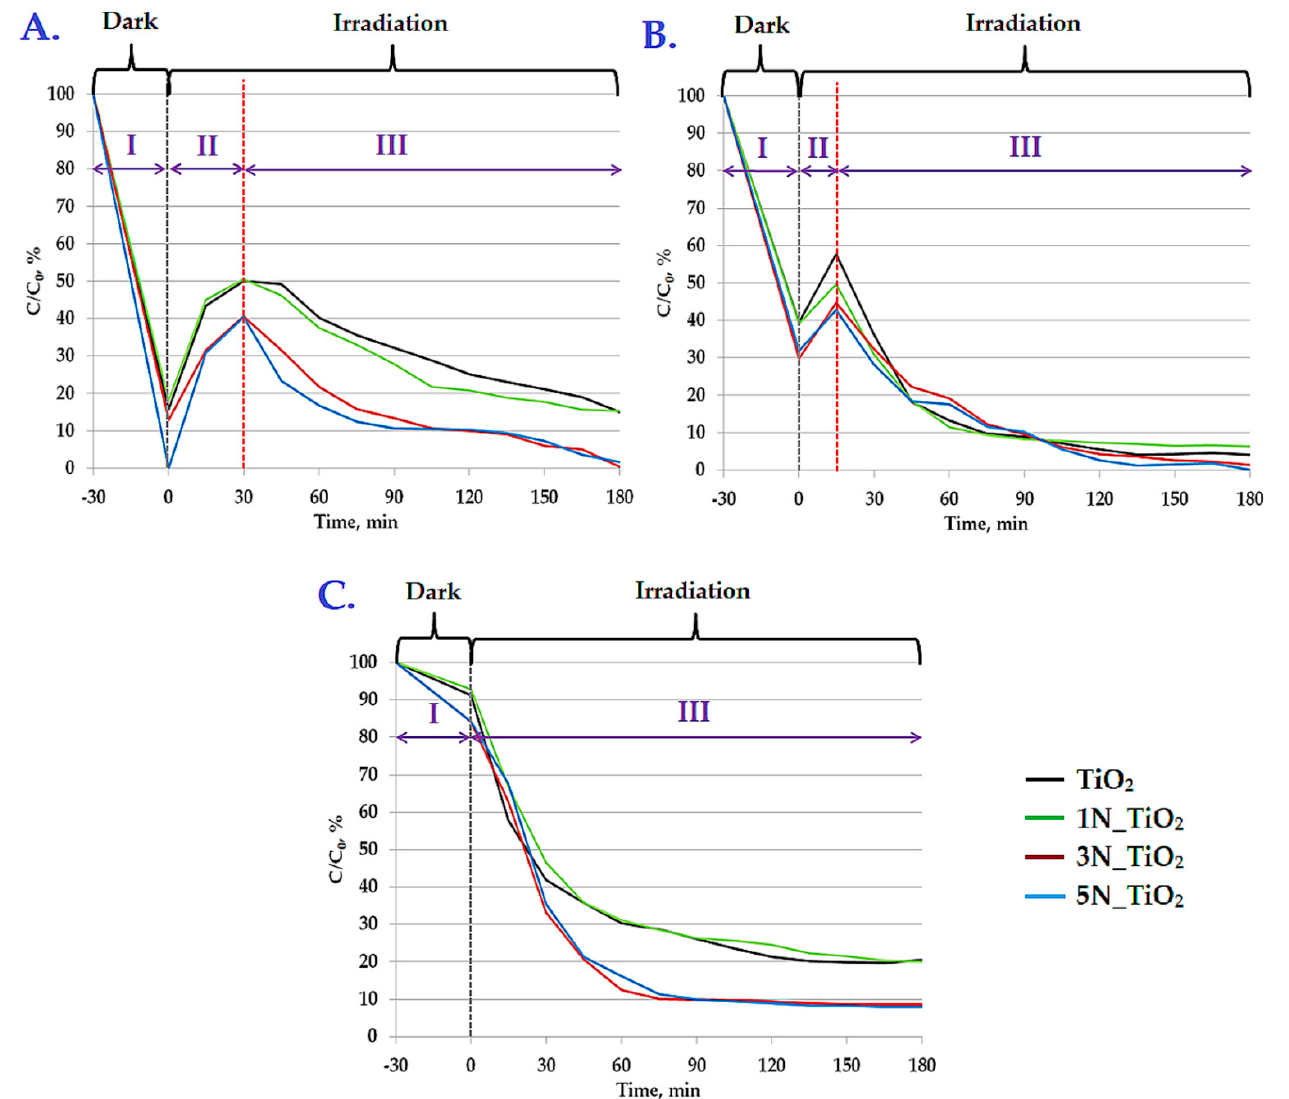
Figure 5. Photodegradation of Acesulfame K in the presence of undoped and nitrogen-doped TiO 2 . The initial concentrations of the compound: 20 ppm ( A ), 50 ppm ( B ), and 100 ppm ( C ). Process stages: ( I ) adsorption under dark, ( II ) desorption and photodegradation under irradiation, and ( III ) photodegradation under irradiation. Photocatalyst concentration: 1 g/L.